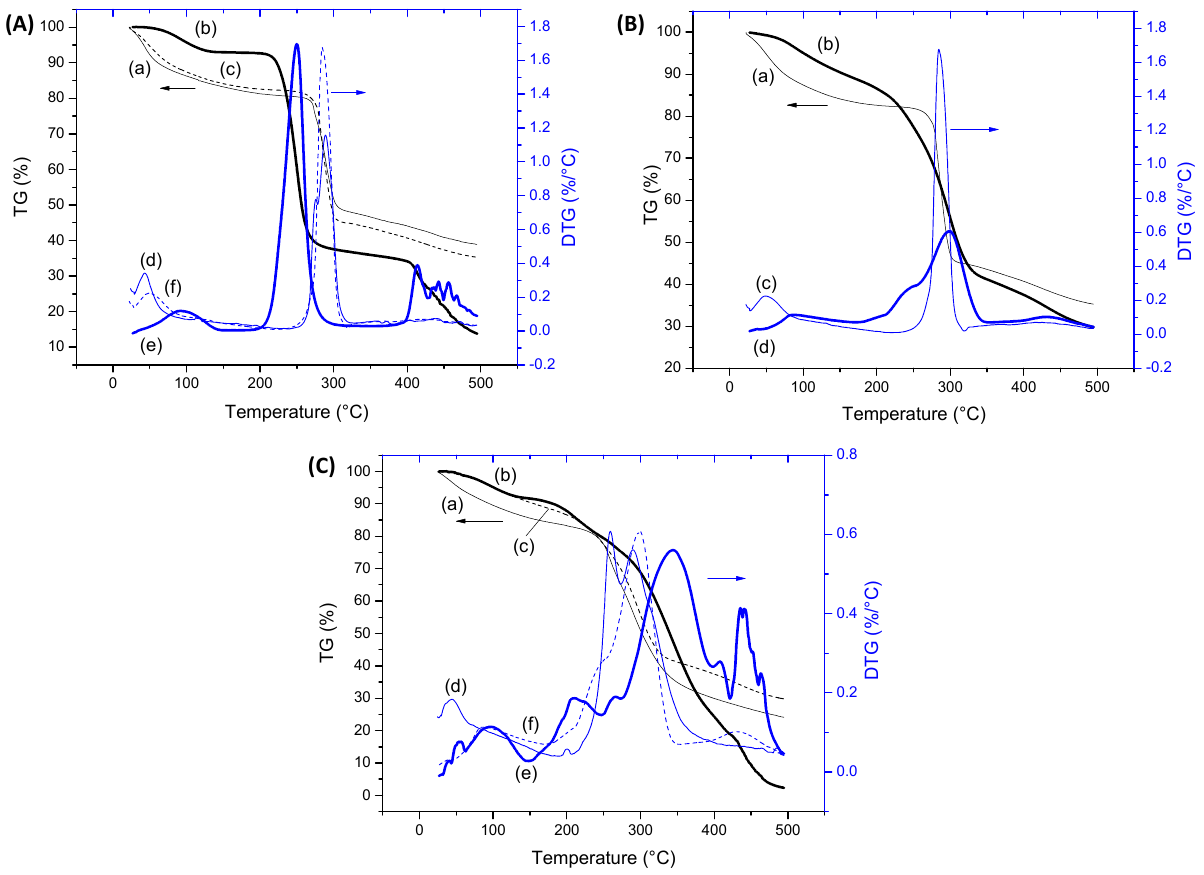
Figure 10. ( A ) TG ( a – c ) and DTG ( d , f ) analysis of CMC-700_CA0 ( ⎯ , solid line), PVA_CA0 ( ⎯ ), and CMC-700:PVA_CA0 (---, dashed line) hydrogels. ( B ) TG ( a , b ) and DTG ( c , d ) analysis of CMC-700:PVA_CA0 ( ⎯ ) and CMC-700:PVA_CA25 ( ⎯ ) hydrogels. ( C ) TG ( a – c ) and DTG ( d , f ) analysis of CMC-700_CA25 ( ⎯ ), PVA_CA25 ( ⎯ ), and CMC-700:PVA_CA25 (---) hydrogels.